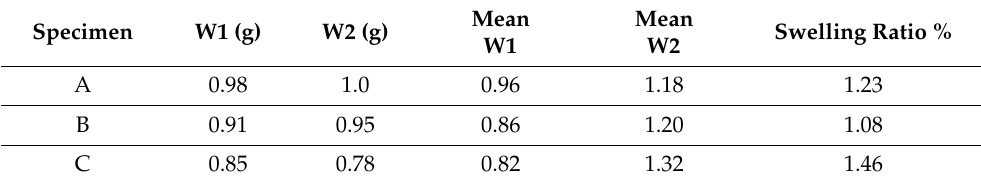
Table 6. Results of water absorption for specimens A, B, and C by applying different ratios of matrix in